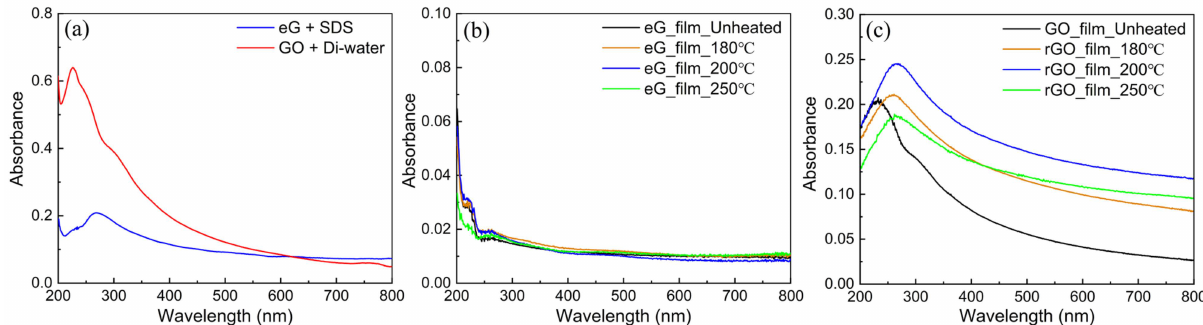
Figure 3. UV-vis-NIR results for ( a ) solution of eG and GO dispersions; and for ( b ) eG- and ( c ) GO-based films on optical